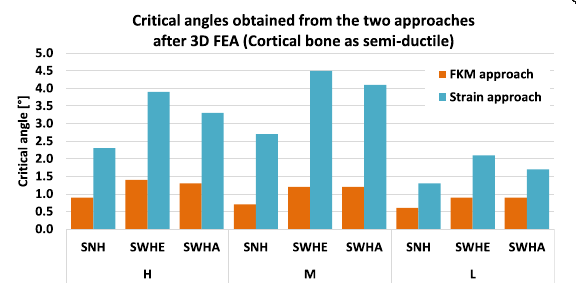
Fig. 22 Critical angles of the specimens: The values obtained with strain approach were higher compared to those obtained with FKM approach. The highest critical angle (4.5°) was obtained for specimen